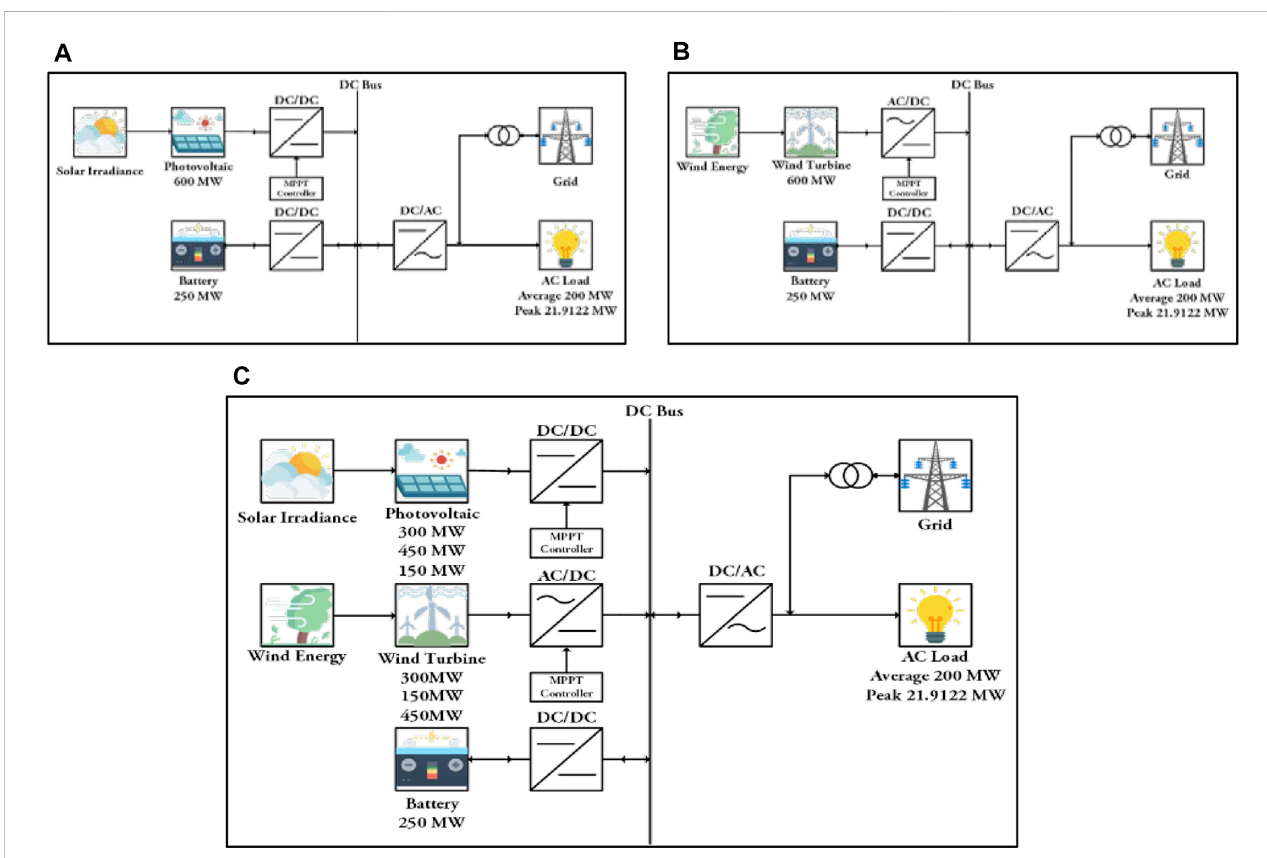
FIGURE 7 Hybrid microgrid with an ESS. (A) PV and battery on-grid connected; (B) wind turbine and battery on-grid connected; (C) PV, wind turbine, and battery on-grid connected with PVs and wind turbines of three different